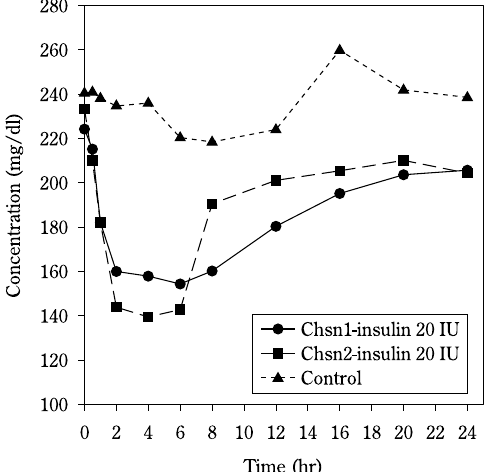
Fig. 7 Effects of transdermal insulin delivery by a chitosan patch on blood glucose levels in NOD-mouse (chsn1 = mw: 50,000, chsn2 = mw: